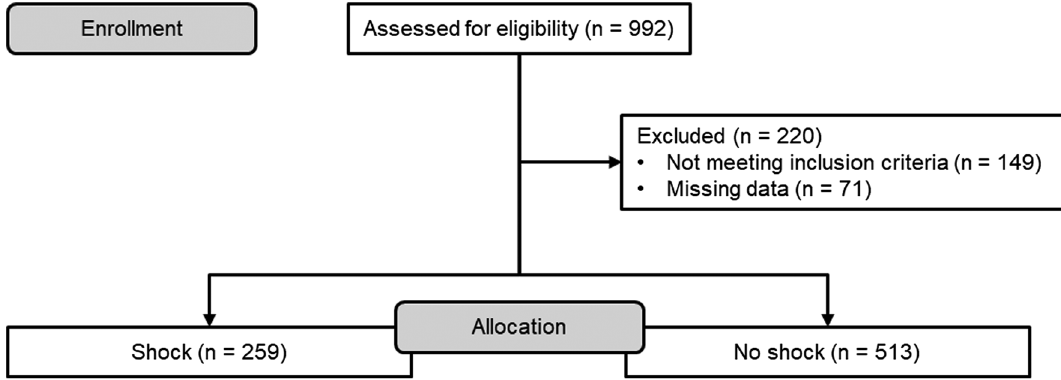
Figure 1. Flow diagram of excluded